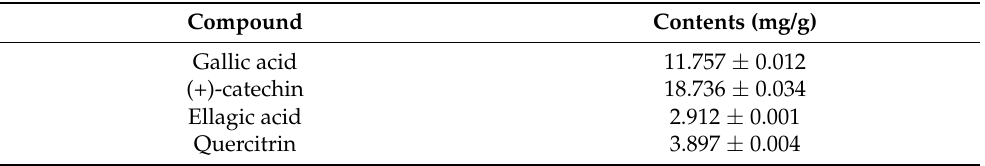
Table 2. Among the four compounds, (+)-catechin (18.736 mg/g) was the most abundant. Table 2. The contents of four compounds in B. coccinea